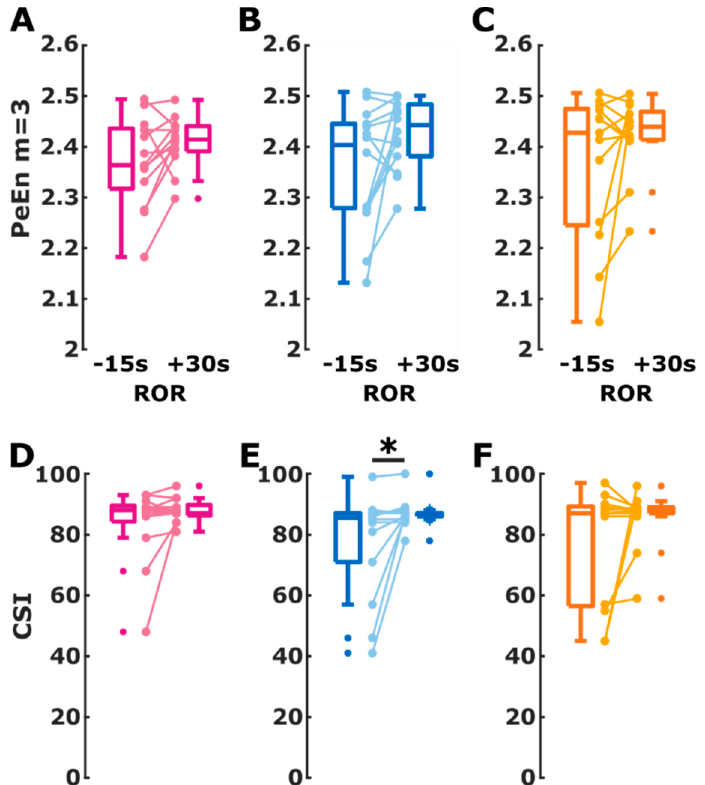
Figure 3. Change in cerebral state index (CSI) and permutation entropy (PeEn) values during return of responsiveness (ROR) from 15 s before ROR to 30 s after ROR for the isoflurane group (purple), propofol group (blue), and sevoflurane group (orange). The box plots indicate the distribution of CSI and PeEn values before and after ROR used for AUC calculation. The connected dots present the change in CSI and PeEn for each single patient. ( A ) The signed rank test indicated a non-significant change with a medium effect size of PeEn in patients assigned to the isoflurane group ( p = 0.057; Hedge’s g = − 0.52 ( − 1.22 − 0.03)). ( B ) In the propofol group, the PeEn of the patients showed a non-significant ( p = 0.0580) increase of medium effect (g = − 0.68 ( − 1.32 − 0.17)). ( C ) PeEn in the sevoflurane group increased non-significantly with a medium effect ( p = 0.2163; g = − 0.77 ( − 1 0.05)). ( D ) There was no significant different in the CSI change within the patients for the isoflurane group ( p = 0.2344) ( E ) The CSI in patients in the propofol group significantly (*) increased ( p = 0.0234; g = − 0.71 ( − 1.20 − 0.33), medium effect) ( F ) For the sevoflurane group the change within the patients was not significant ( p = 0.4453).